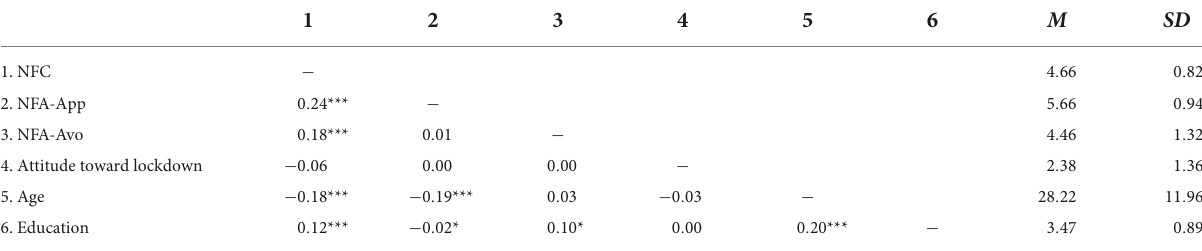
TABLE 1 Descriptive statistics and correlations between